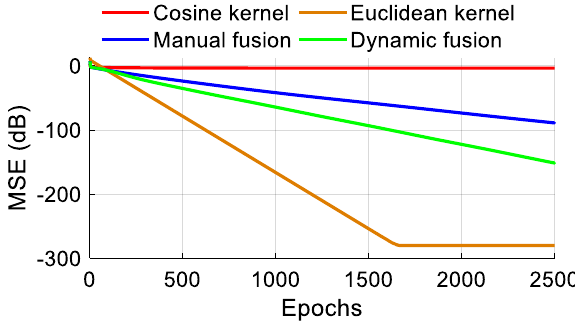
Figure 8. Comparison of mean square error curves of the training phase of the different kernels for pattern recognition.